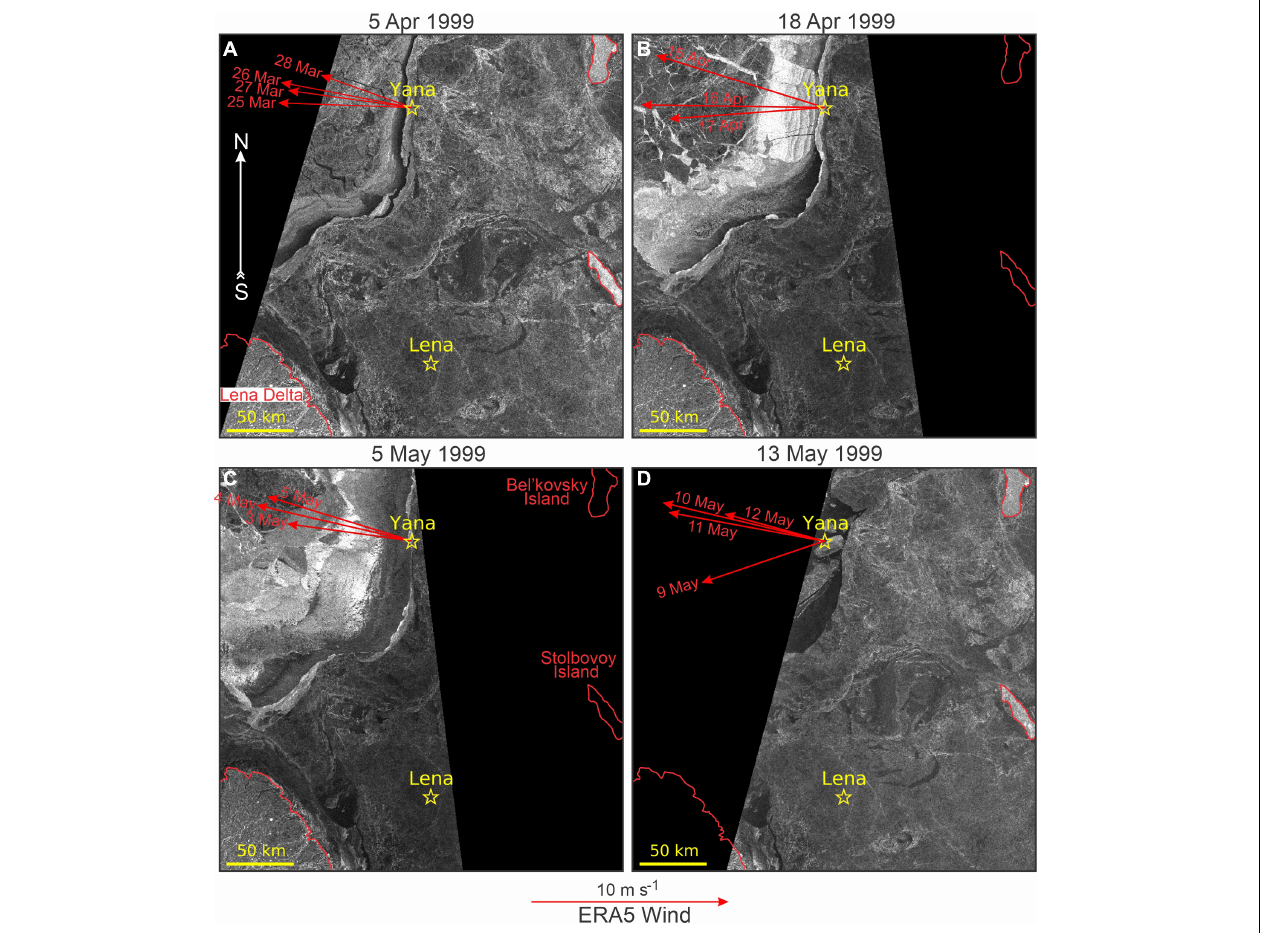
FIGURE 6 | RADARSAT-1 ScanSAR satellite images show the evolution of the Laptev Sea polynya in April–May 1999: (A) 5 April 1999, (B) 18 April 1999, (C) 5 May 1999, and (D) 13 May 1999. Black areas off the landfast ice edge are associated with polynya open water. The gray and white strips in (A–C) are associated with 5–30 cm thick newly formed sea ice in polynya area. Red arrows show ERA5 winds observed at Yana before image was taken. All other designations are similar to those in Figure 5 . © CSA (1999).